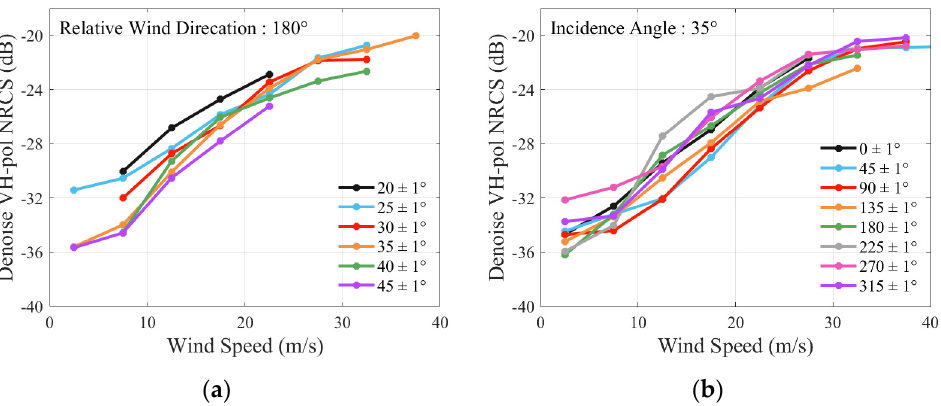
Figure 8. Influence of wind speed on the cross-polarized NRCS for ( a ) different incidence angles when the relative wind direction is 180 ° , and ( b ) different relative wind directions when the incidence angle is 35 ° .